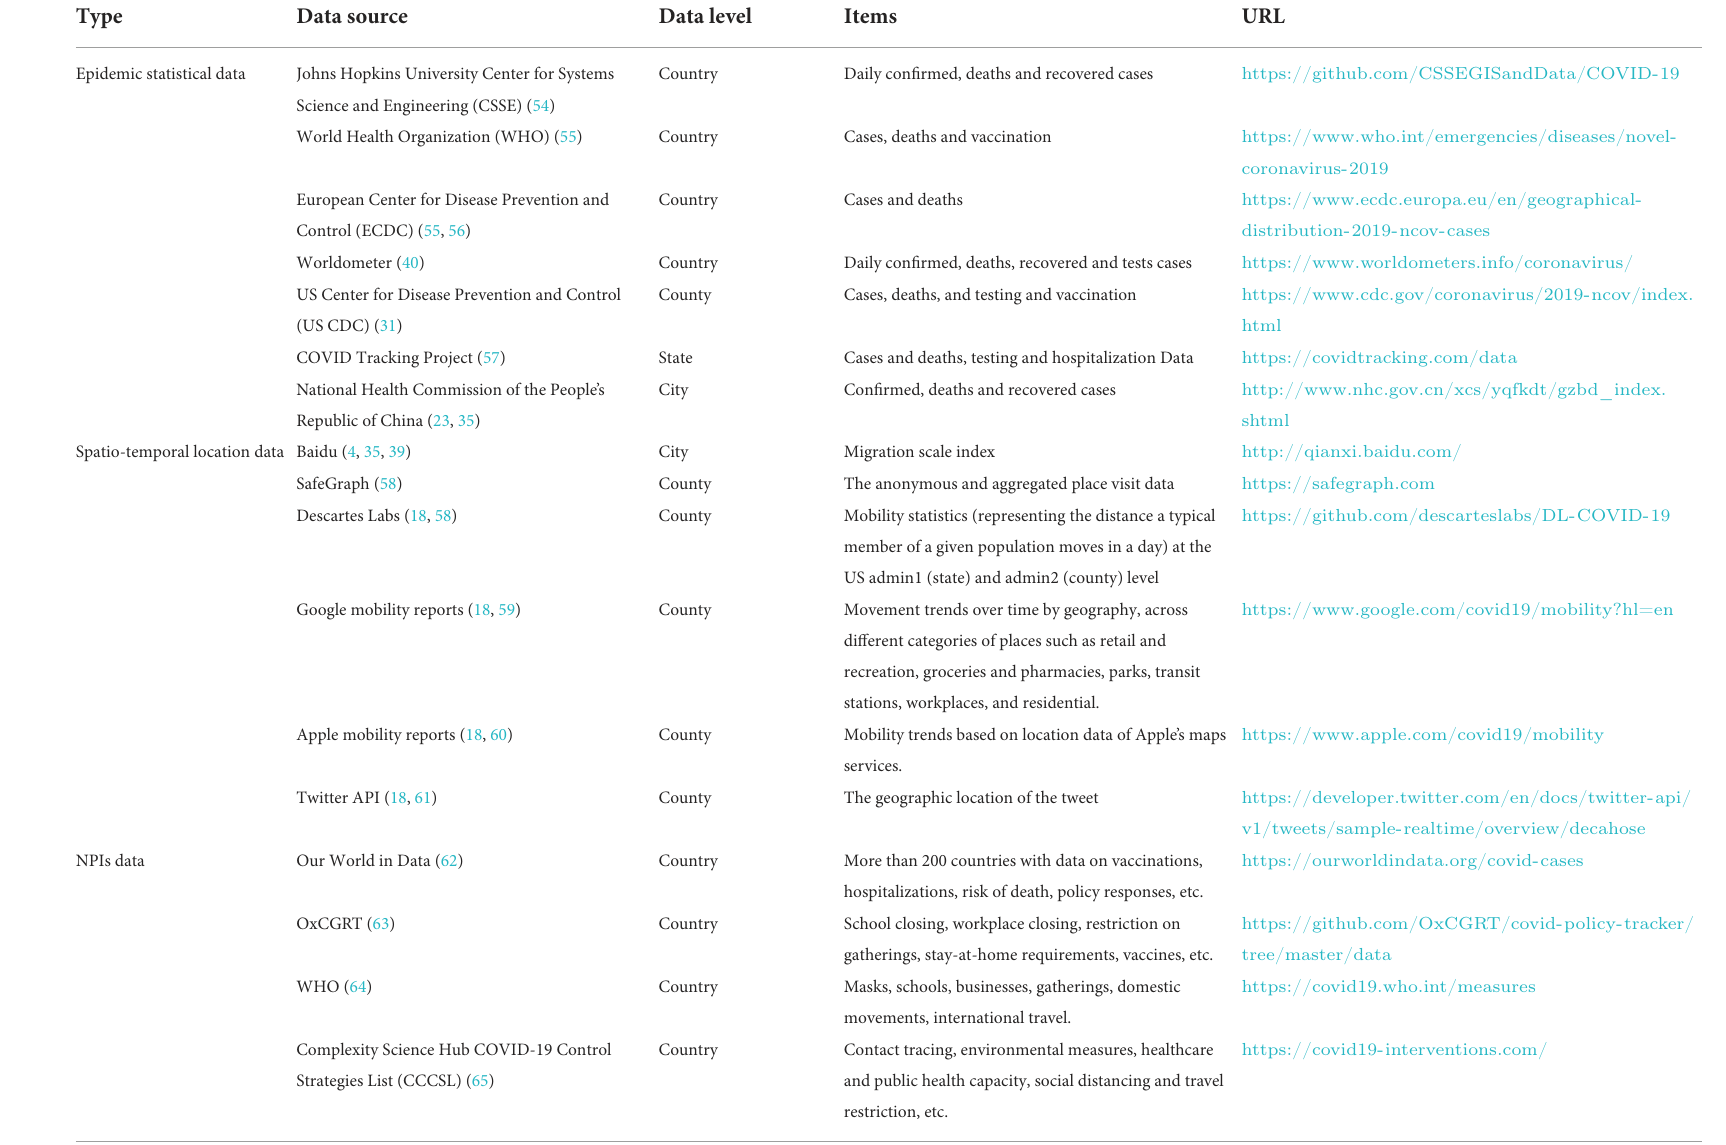
TABLE 3 Grouping of COVID-19 spatio-temporal dataset sources into epidemic statistical data, spatio-temporal location data and NIPs